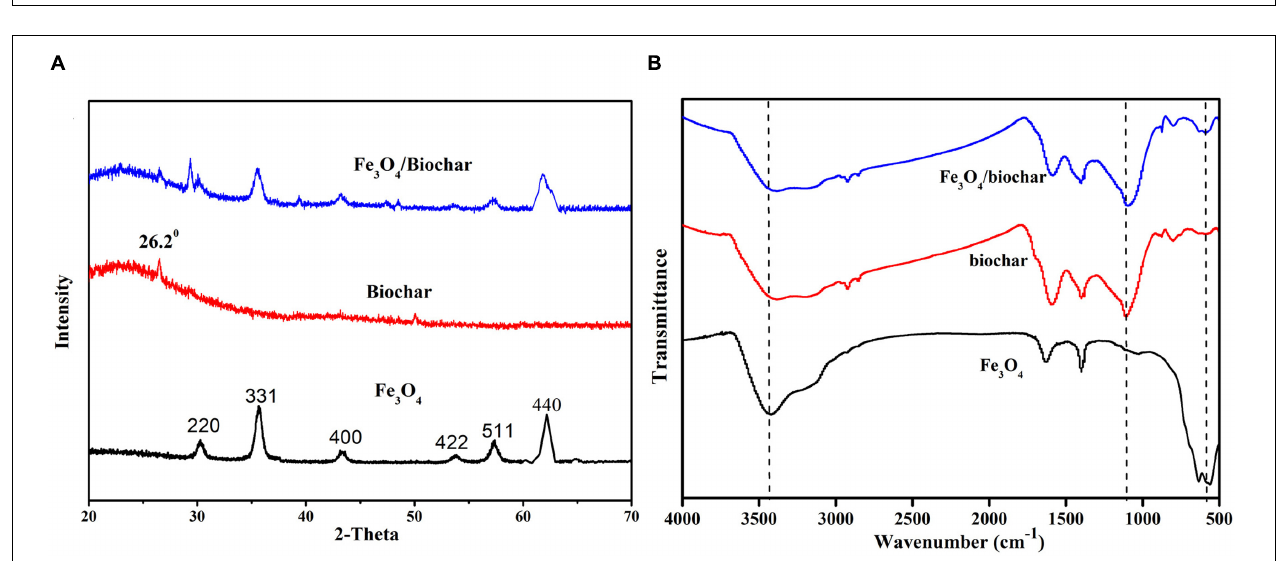
FIGURE 1 | Scheme of preparation of Fe 3 O 4 /biochar composite and the immobilization of photosynthetic bacteria (PSB) bacteria.